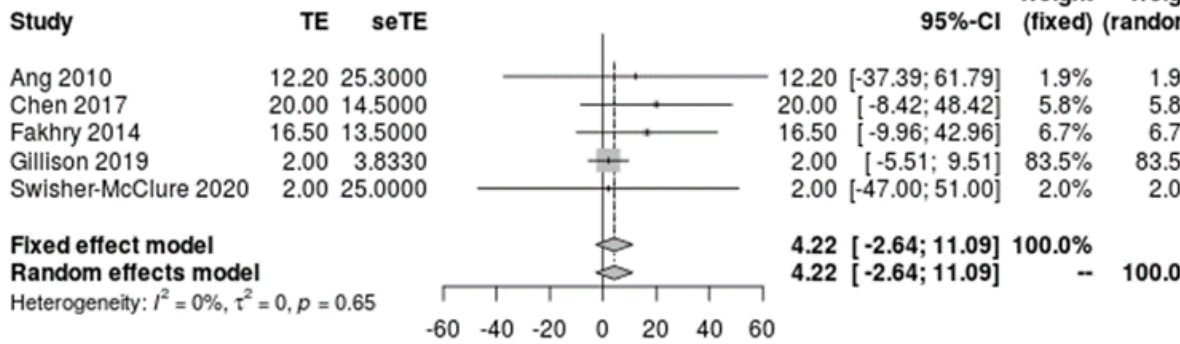
Figure 4. Funnel plot of all included studies. Table 2. Meta-analyses of patient sex and race and I 2 values amongst all studies and patients. Identifier